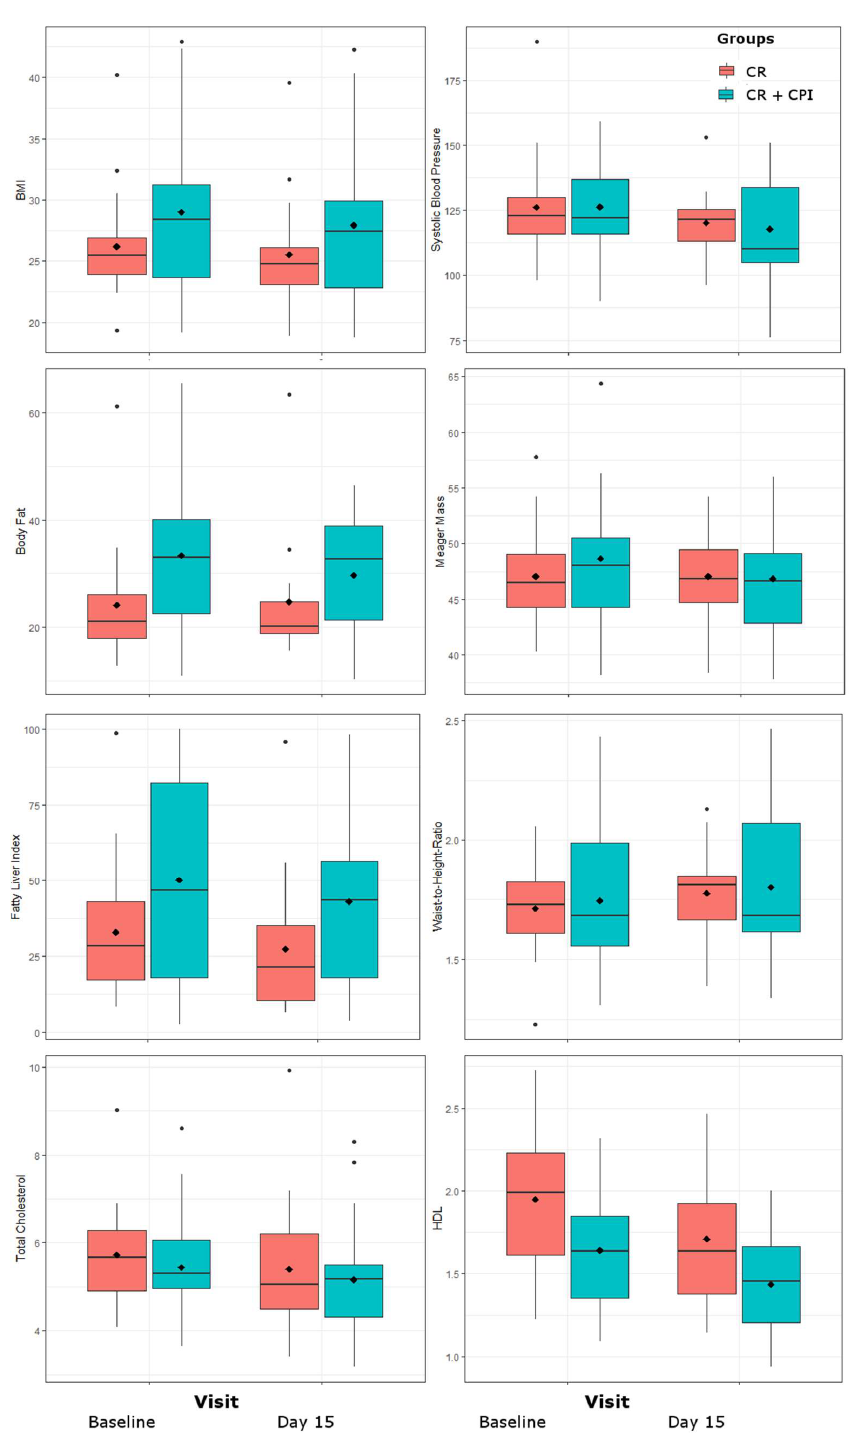
Figure 2. Changes in anthropometric parameters body mass index (BMI), waist-to-height-ratio, fatty liver index, as well as total and HDL cholesterol and systolic blood pressure over the study period of 14 days. Values are grouped by treatment groups of caloric restriction (CR) alone and CR together with clinical psychological intervention (CPI).